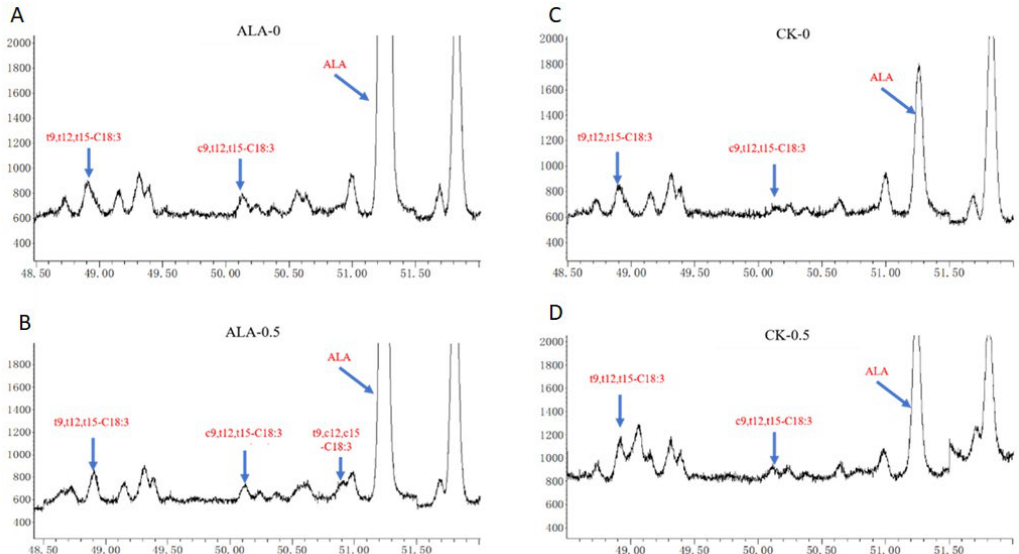
Figure 1. C18:3 fatty acid from fermentation in vitro. ( A ): ALA group fermented for 0 h; ( B ): ALA group fermented for 0.5 h; ( C ): CK group fermented for 0 h; ( D ): CK group fermented for 0.5 h.